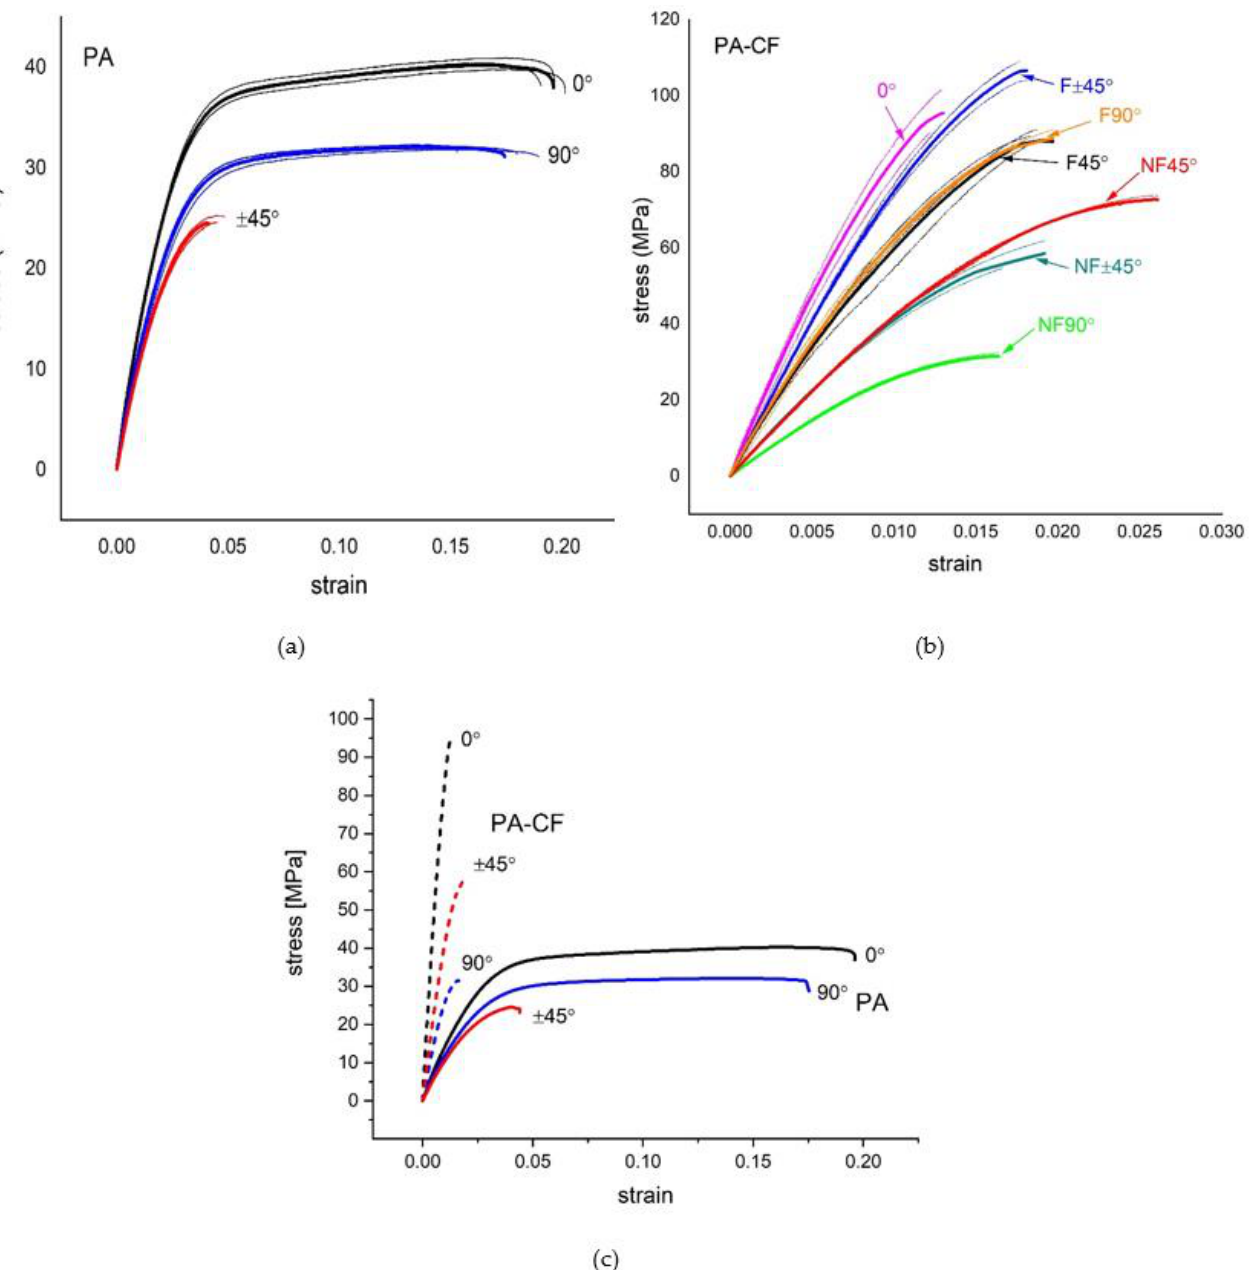
Figure 3. Engineering stress – strain curves obtained by tensile tests. ( a ) PA, ( b ) PA – CF (F: framed, NF: not framed) (thin curves are individual tests whereas bold ones are the averaged curves), and ( c ) a comparison of the averaged curves for PA and PA – CF (solid curves are PA and dashed curves are PA – CF). Table 4. Tensile properties of PA and PA – CF.